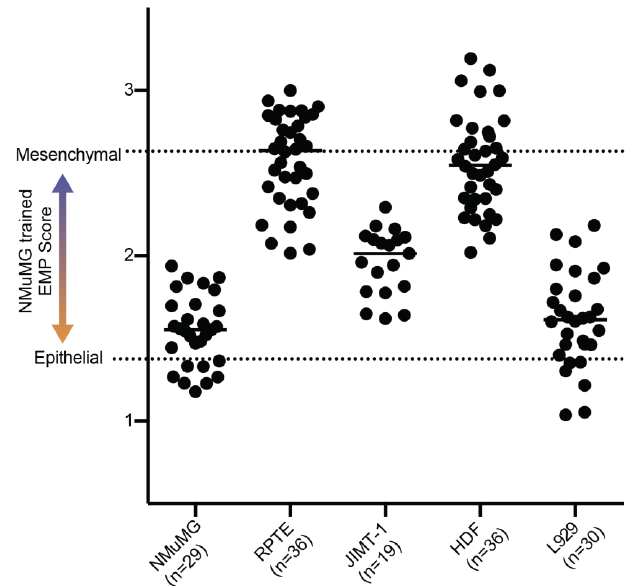
Figure 5. EMP scores of established cell lines using the NMuMG-trained classifier. Each dot represents the EMP score calculated from the average of all cells in an image. Fields were taken over 3 experiments.